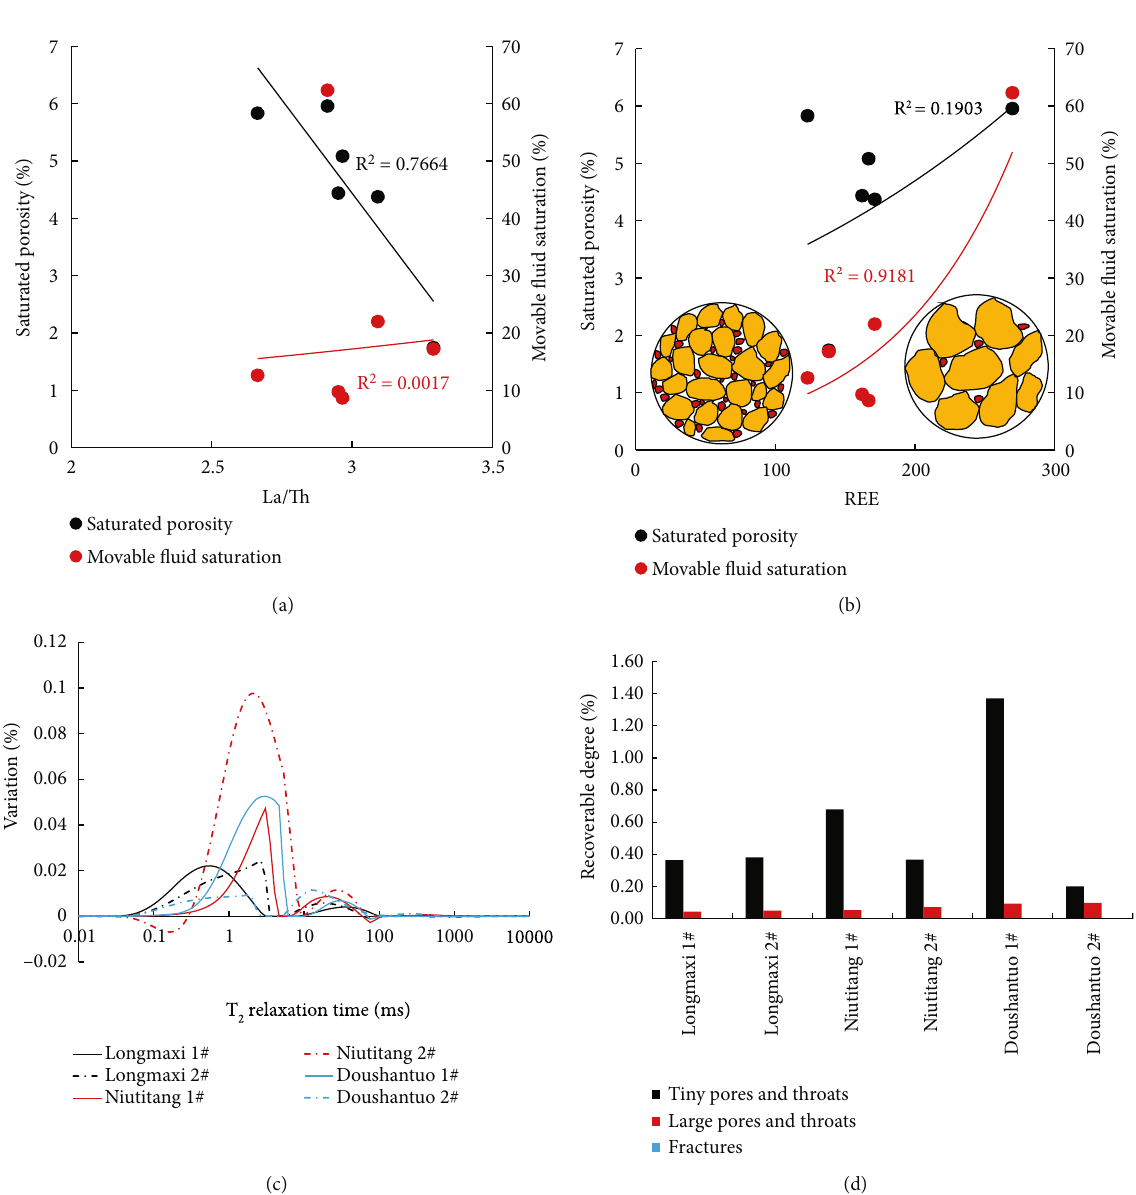
Figure 6: The relationships between (a) La/Th and saturated porosity and movable fl uid saturation, (b) REE and saturated porosity and movable fl uid saturation, (c) recoverable degree distributions, and (d) recoverable degree in the di ff erent research